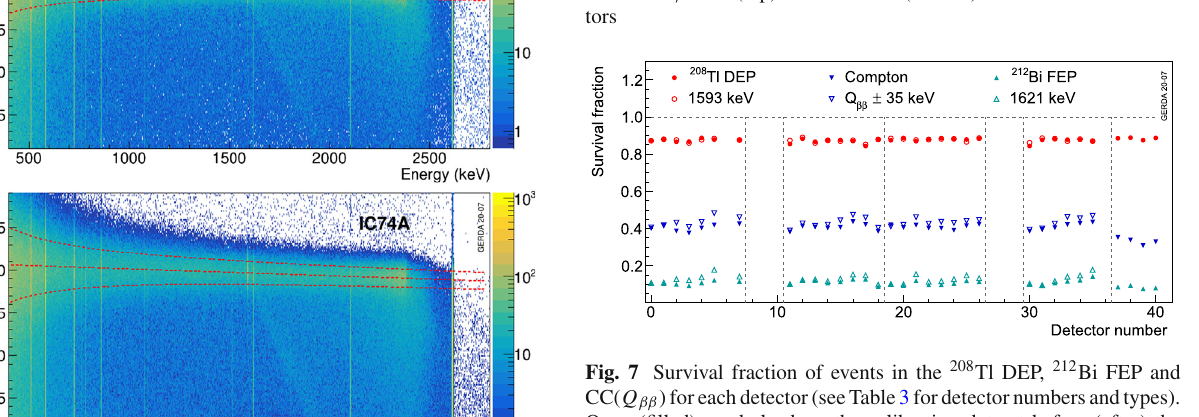
the 3% relative level during the whole data collection period when applied to Compton continuum events at Q ββ .